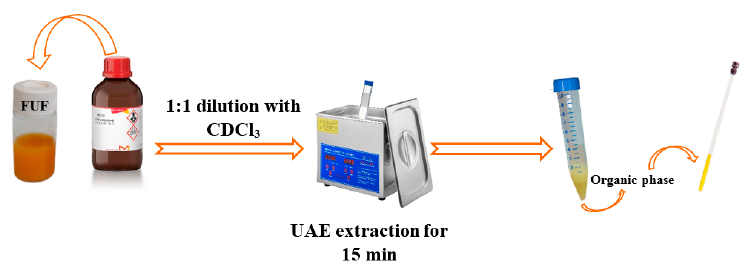
Figure 3. Organic phase sample